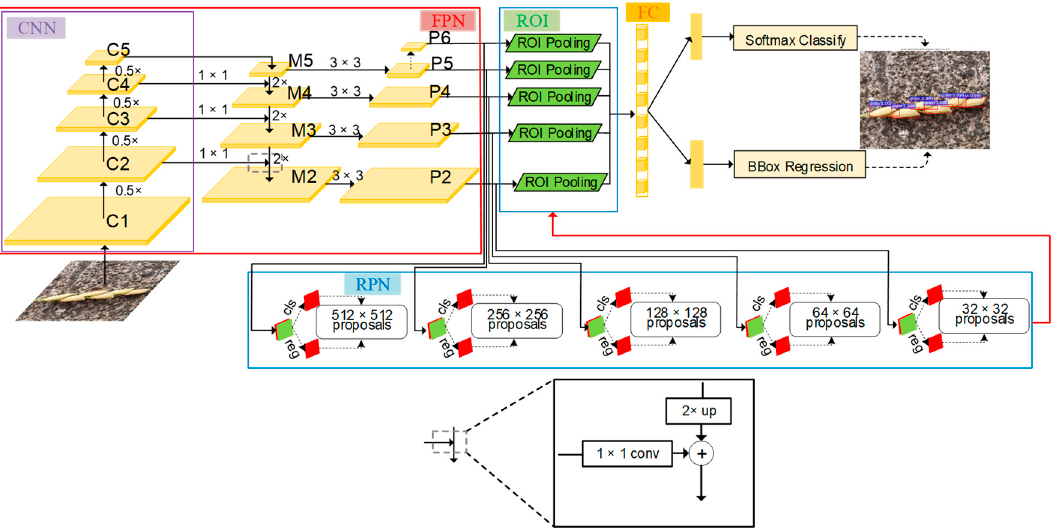
Figure 3. The architecture of the grain detection model.